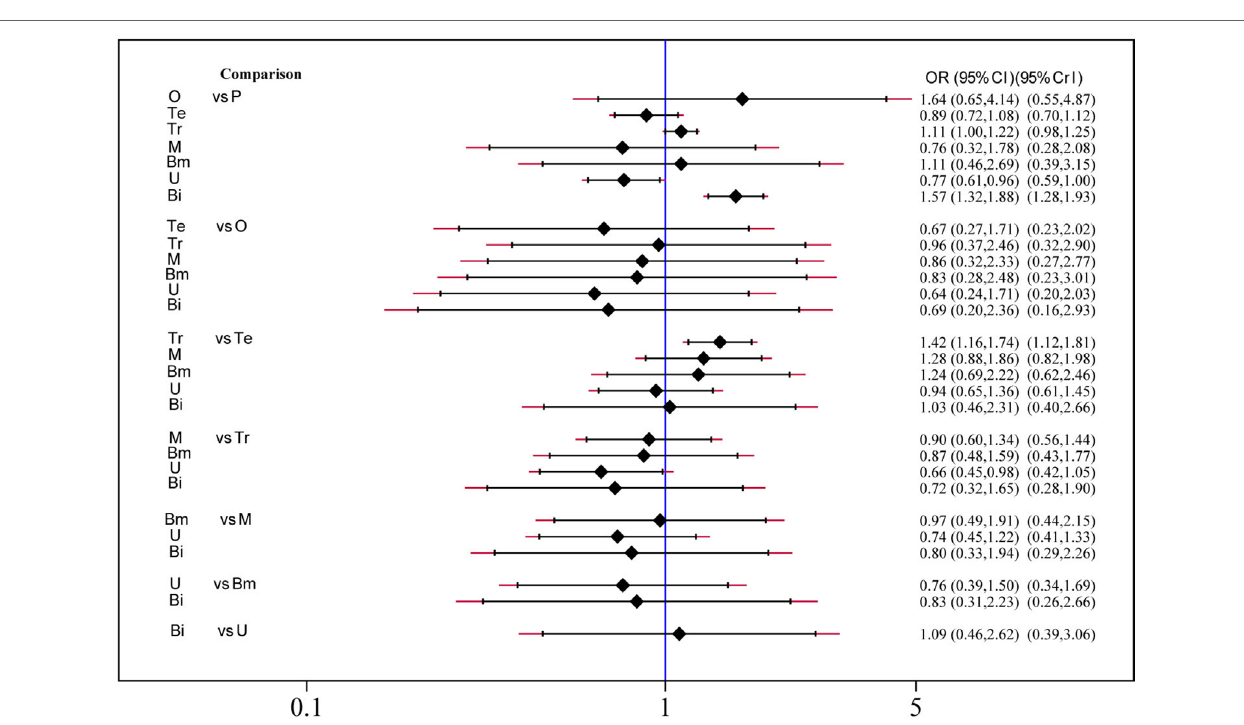
FIGURE 3 | Efficacy analysis results for 2-h pain-free of six treatment modalities. OR, odds ratio; CI, confidence interval; PrI, predictive interval; O, olcegepant; Te, telcagepant; Tr, triptan; M, MK3207; Bm, rimegepant (BMS-927711); U, ubrogepant; Bi, BI 44370; P, placebo.